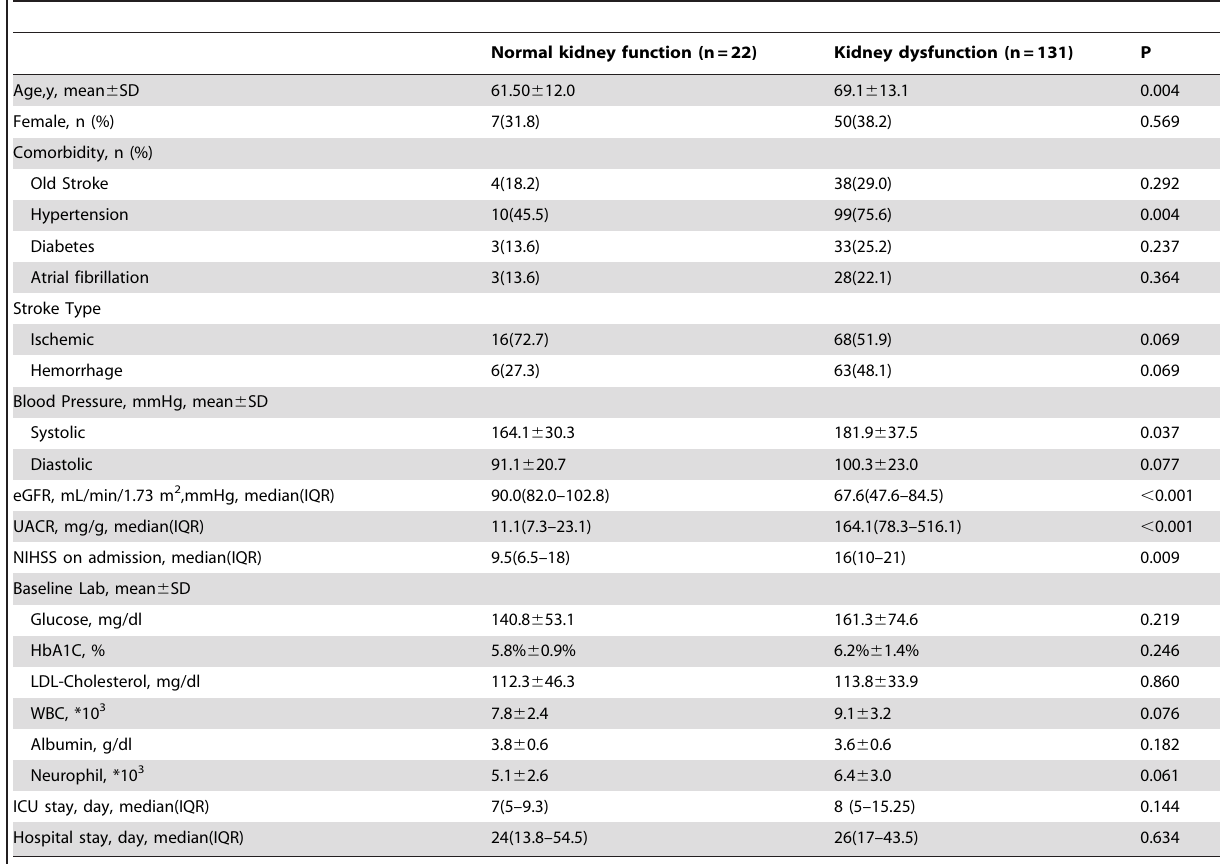
Table 1. The clinic characteristics of the patients with and without kidney